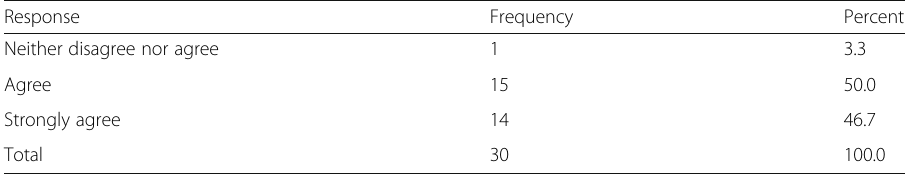
Table 3 Use of advanced management information systems Response